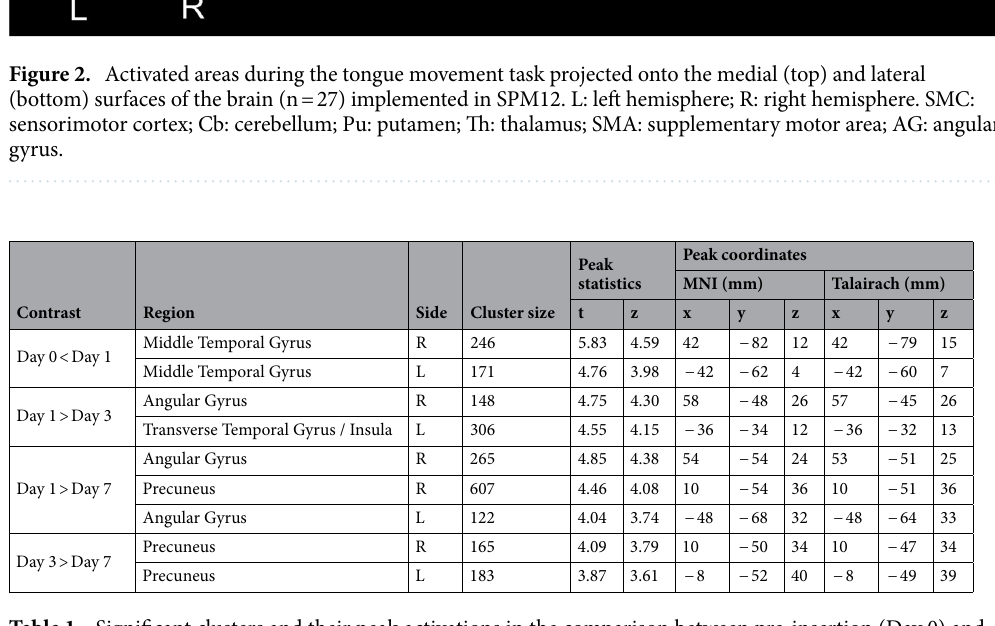
Table 1. Significant clusters and their peak activations in the comparison between pre-insertion (Day 0) and immediately after insertion (Day 1), and between Days 1, 3, and 7 after insertion are listed. Brain regions were defined according to the peak coordinate of the Talairach atlas. MNI montreal neurological institute.